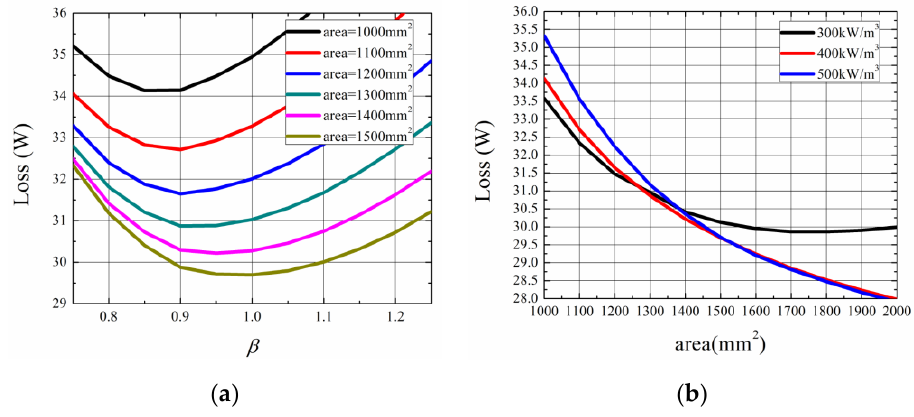
Figure 13. Core loss graph with β and γ substituted into the calculation: ( a ) curve representing loss according to β value for various core areas; ( b ) curve representing loss according to area for various Pcv